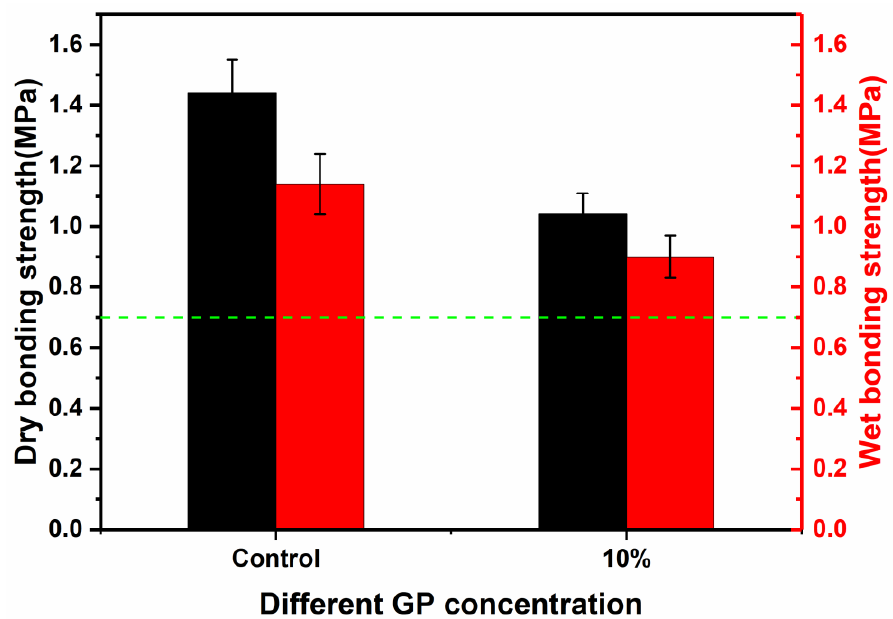
Figure 11. Dry and wet bonding strength of control wood and 10% GP concentration modified wood, glued by PF resin adhesive.